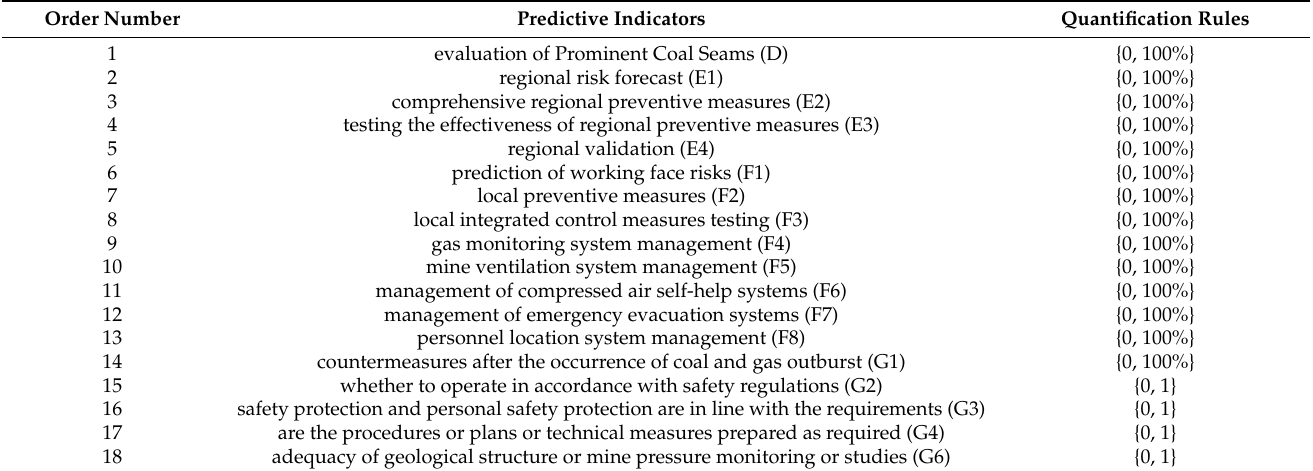
Table 5. Quantification rules for qualitative